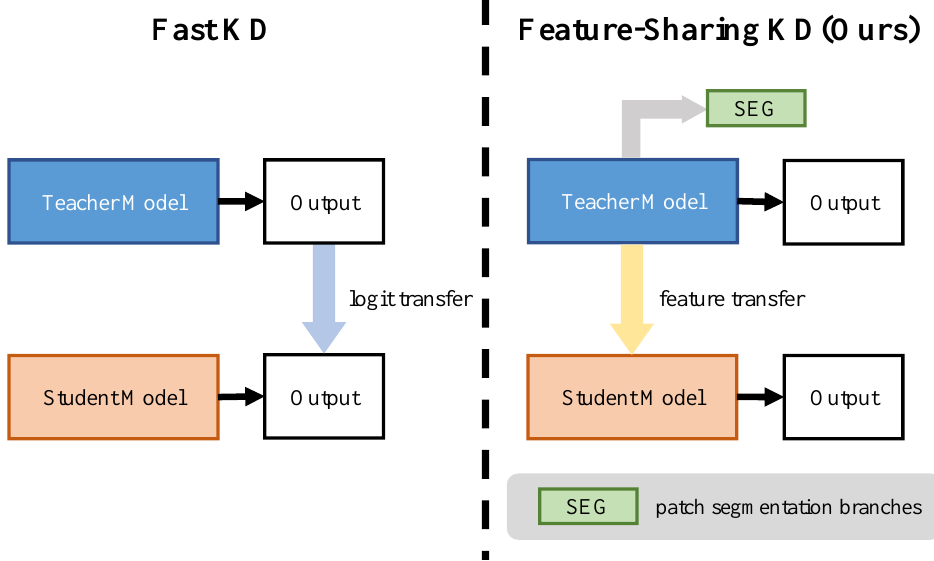
Figure 1. Different from Fast-KD [12], our proposed FSF-LD focuses on intermediate features and transfers them in an effective way. Moreover, to improve the teacher model’s performance, we design a multi-task structure to pretrain the teacher model. The details are provided in Section